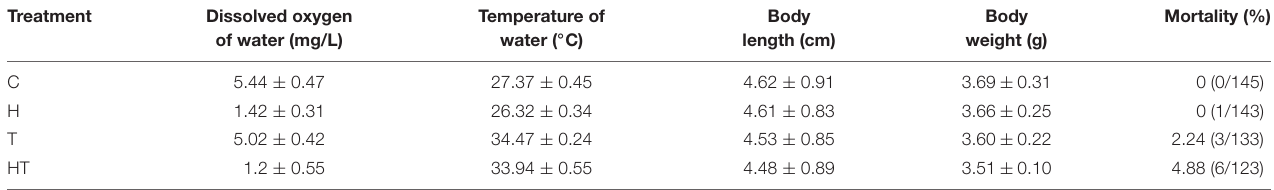
TABLE 1 | Water parameters, fish length and weight, and mortality in control (C), hypoxic (H), thermal (T), and hypoxic-and-thermal (HT) treatment ABR groups. Treatment Dissolved oxygen of water (mg/L)